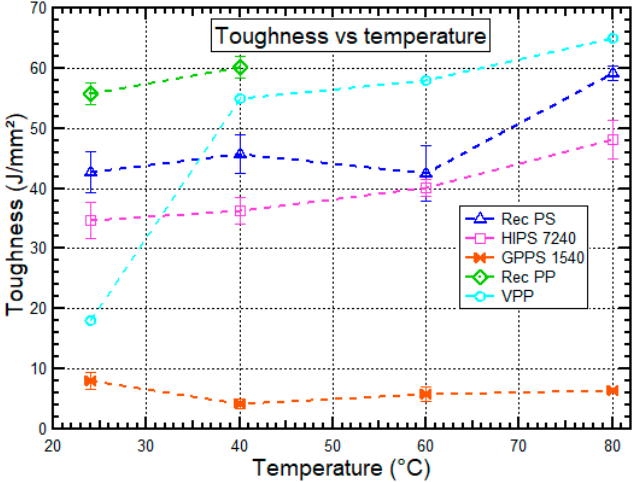
Figure 7. Toughness vs. temperature behavior for HIPS 7240, GPPS 1540, recycled PS, recycled PP, and virgin PP at 24 °C, 40 °C, 60 °C, and 80 °C. Data for virgin PP was obtained from Sahin et al. [52].